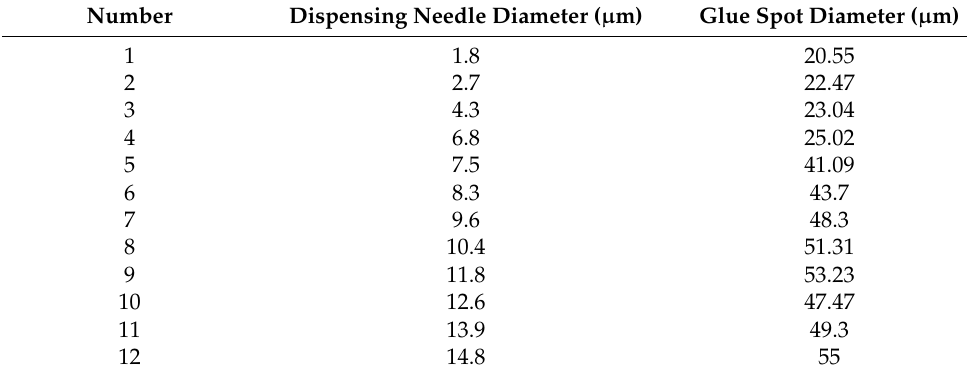
Table 4. Needle diameter versus glue spot